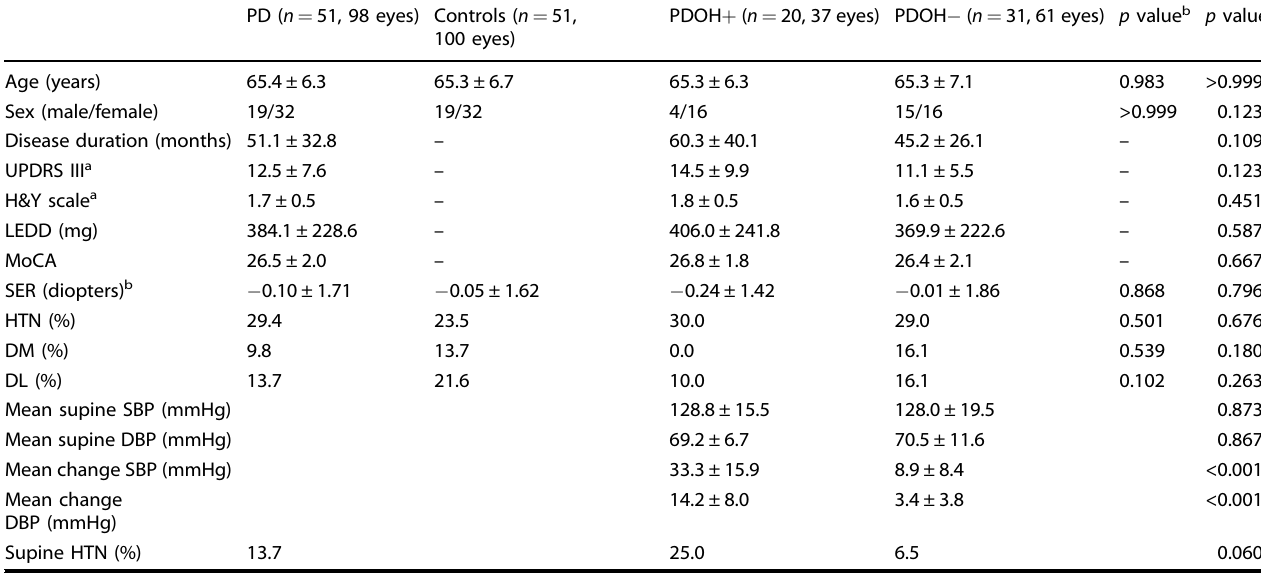
Table 1. Demographics and clinical characteristics of the participants. PD ( n = 51, 98 eyes) Controls ( n = 51, 100